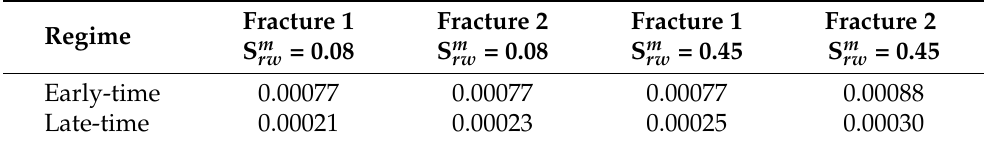
Figure 19. Wetting front position in 0.5 mm (Fracture 1) and 1.1 mm-aperture (Fracture 2) fracture sets of model TUFF2D as a function of time. ( a ) low rainfall intensity, and ( b ) high intensity scenario. The reference depth 0.0m-is that of the soil-bedrock interface. Note that the front moves much faster in the model at a matrix water saturation of 0.45 than at a hypothetical residual water saturation (moisture retention capacity) taken as 0.08. Table 4. Average wetting front velocity (m/s) in the fractures in model TUFF2D, low precipitation rate (case A).